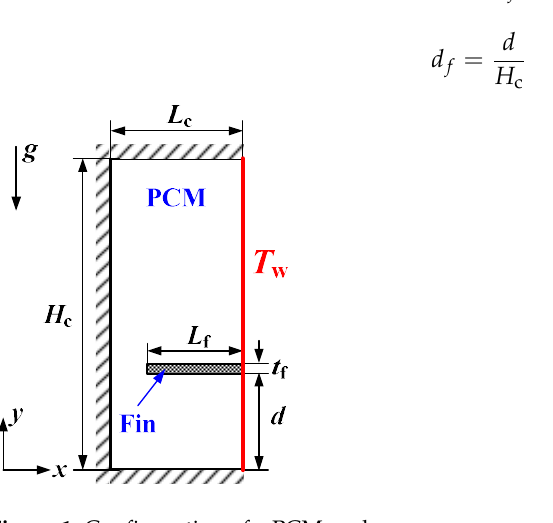
Figure 1. Configuration of a PCM enclosure. Table 1. Thermo-physical properties lauric acid [27,33,42].